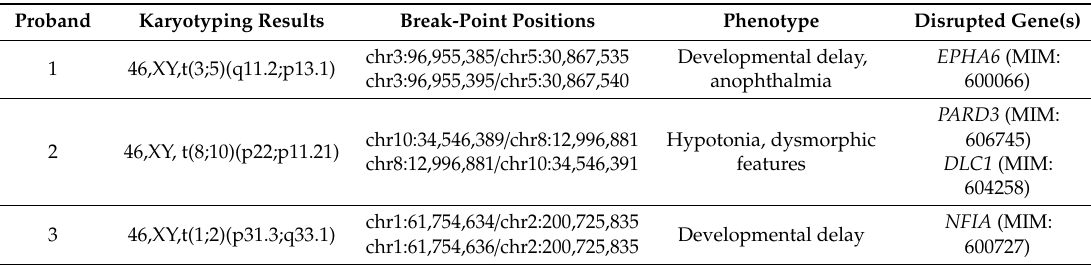
Table 1. Summary of the results of all the